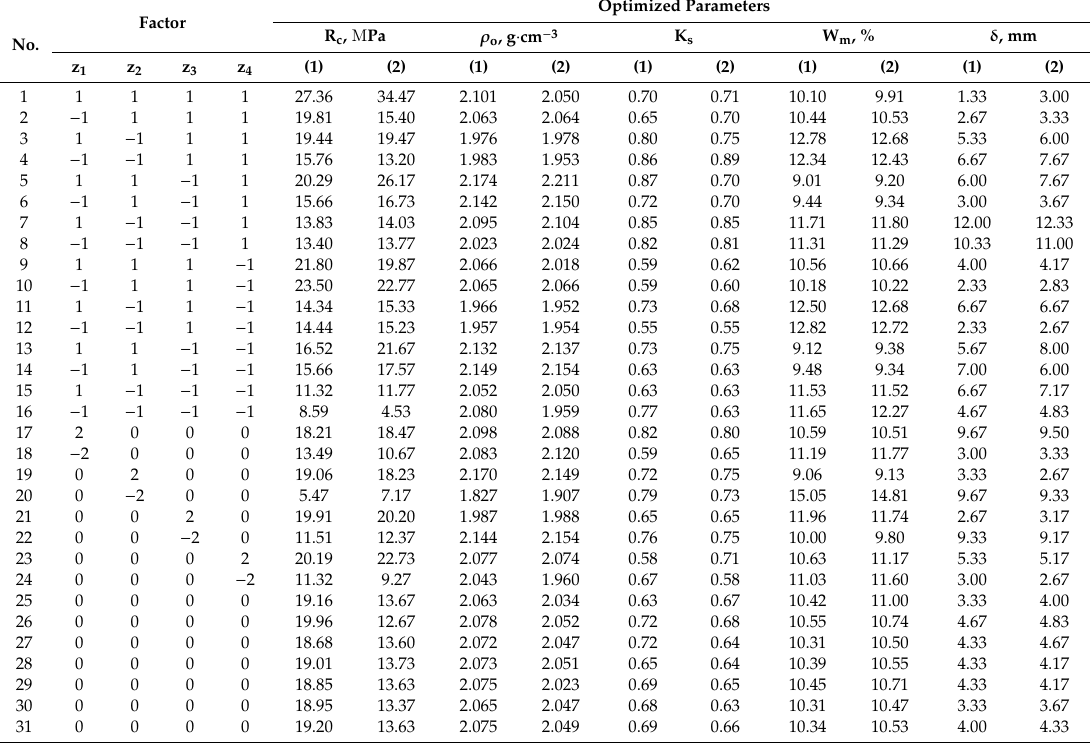
Table 4. Properties of testing samples after carbonation in dynamic (1) and static (2) ways.